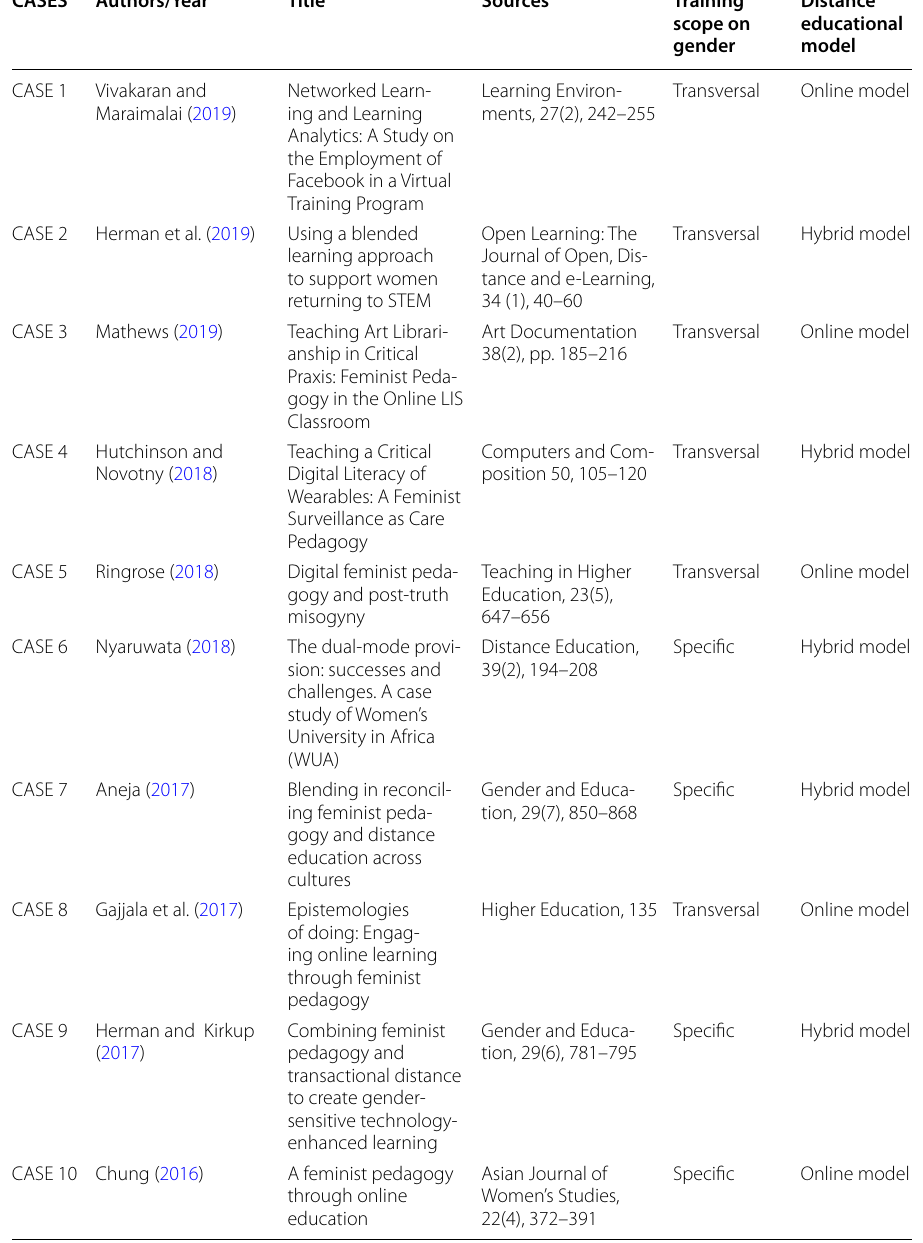
Table 1 Selection of